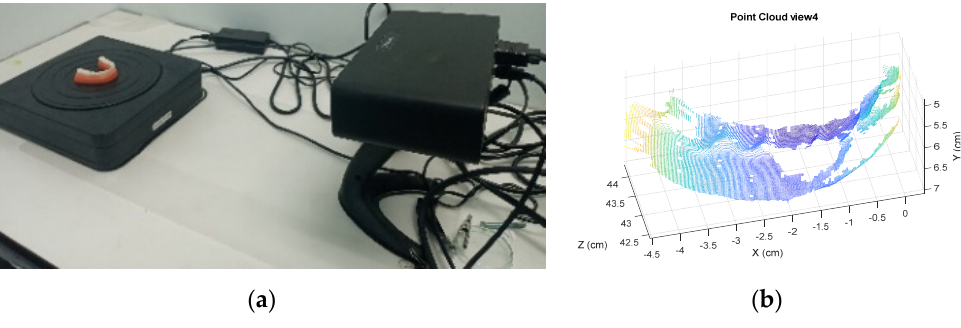
Figure 7. ( a ) Hardware setup and ( b ) point-cloud view.